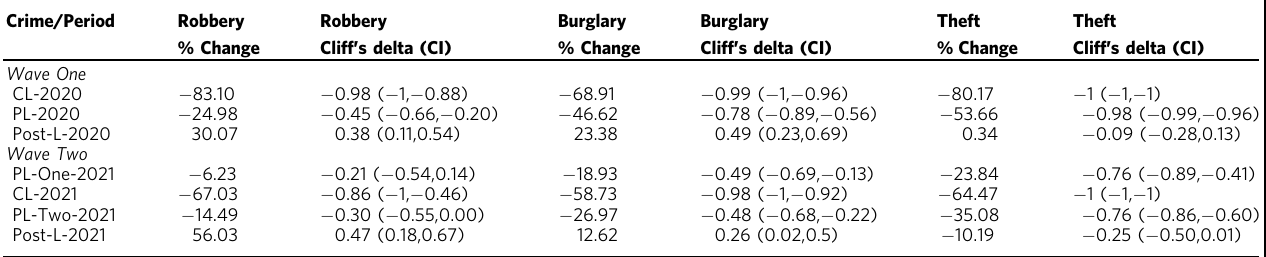
Table 5 The percentage difference between actual and predicted registered property offences along with effect size (Cliff ’ s Delta) during various phases of lockdowns in both waves in 2020 and 2021 in Tamil